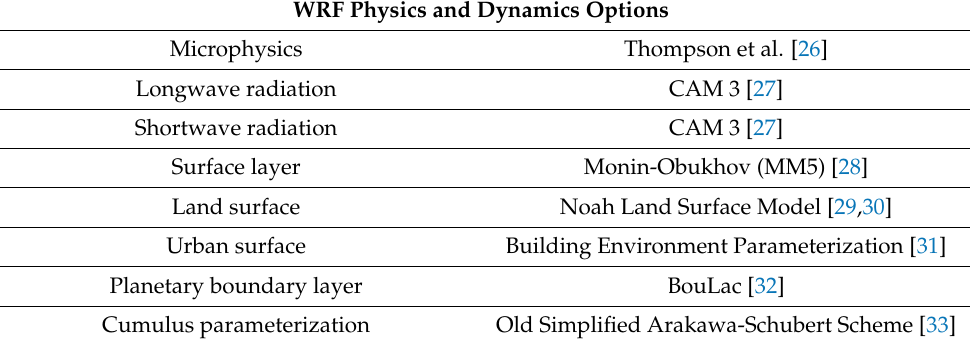
Table 1. Selected weather research and forecasting model, advanced research WRF version, physics and dynamics namelist